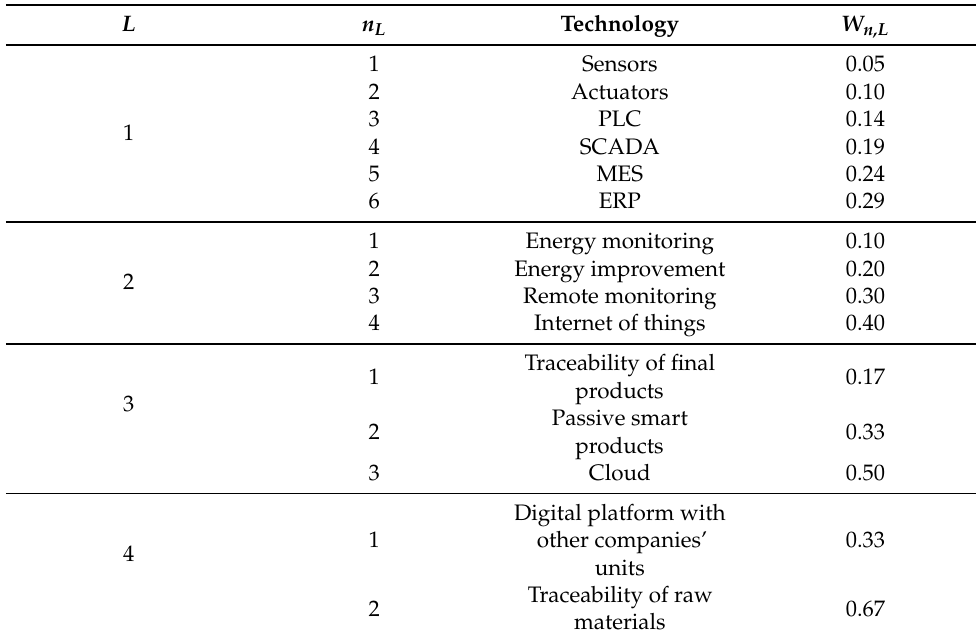
Table 5. Calculated W n,L values related to each